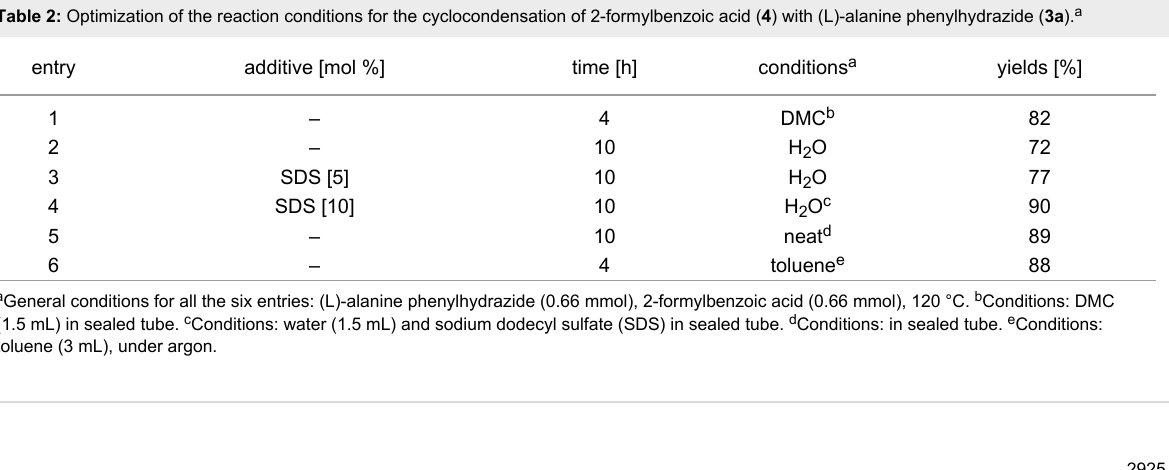
Table 2: Optimization of the reaction conditions for the cyclocondensation of 2-formylbenzoic acid ( 4 ) with (L)-alanine phenylhydrazide ( 3a ).